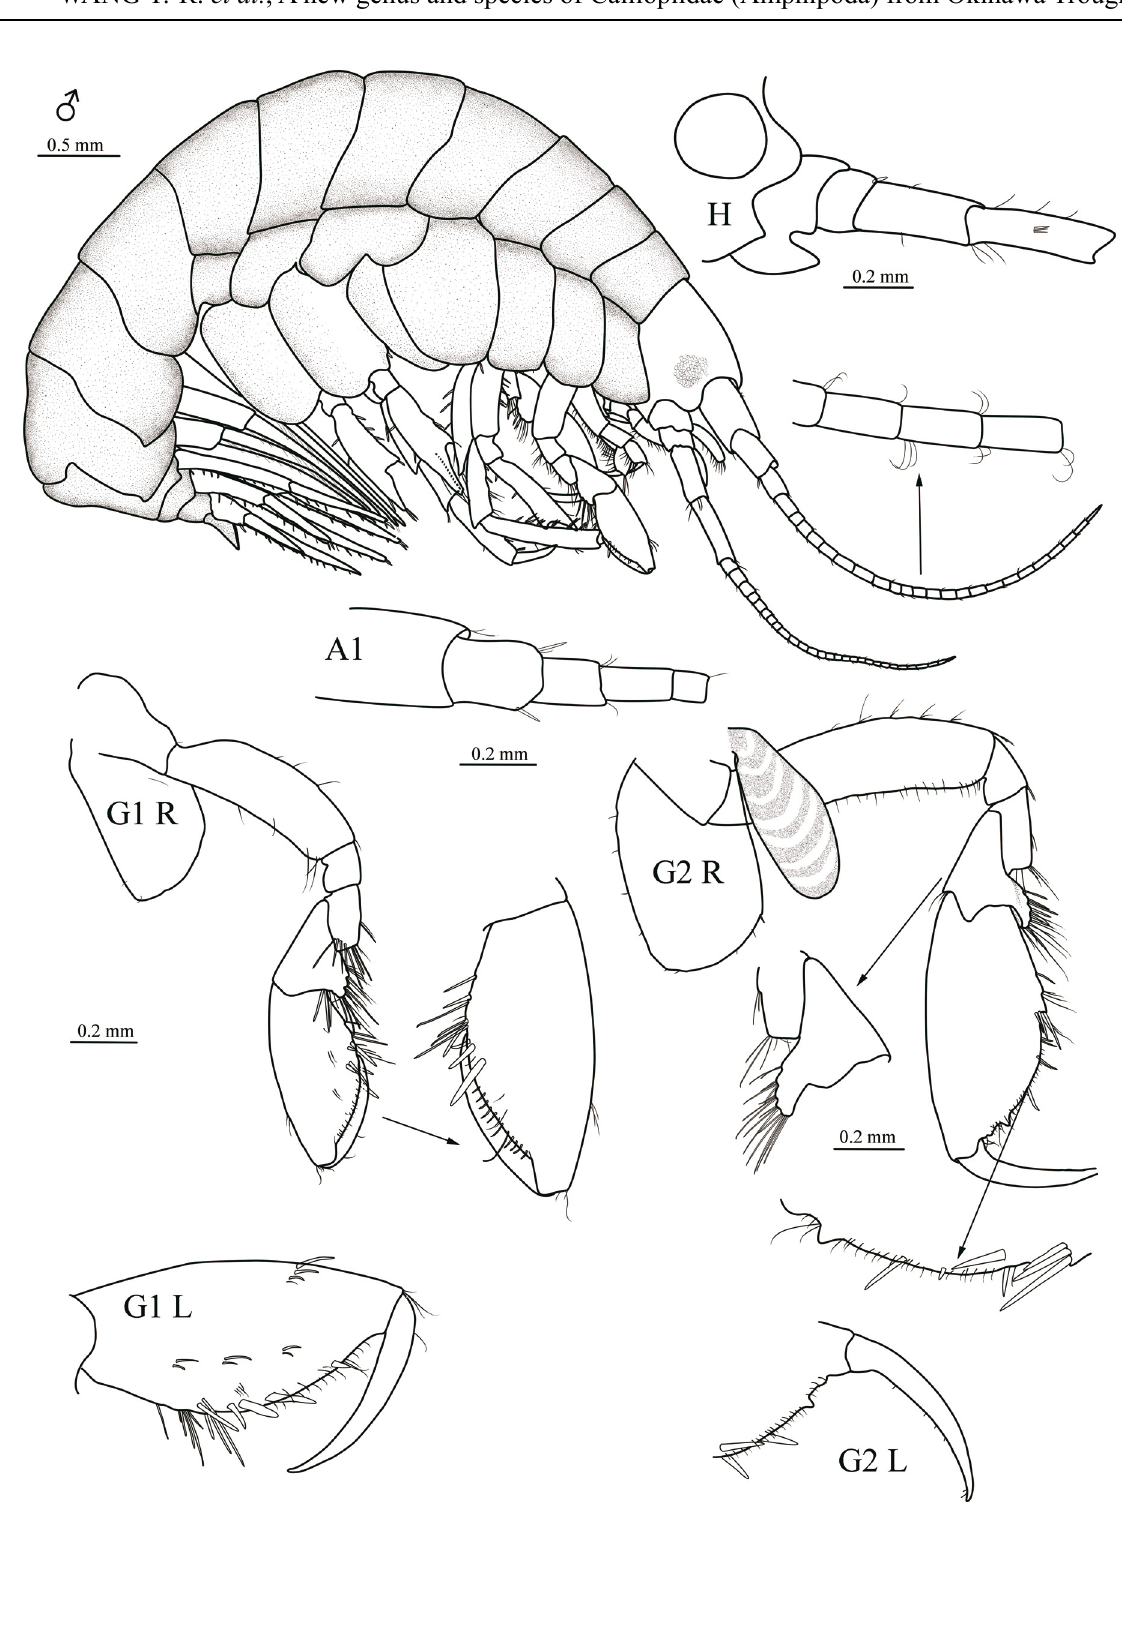
Fig. 1. Bathya brevicarpus gen. et sp. nov., holotype, ♂ (MBM